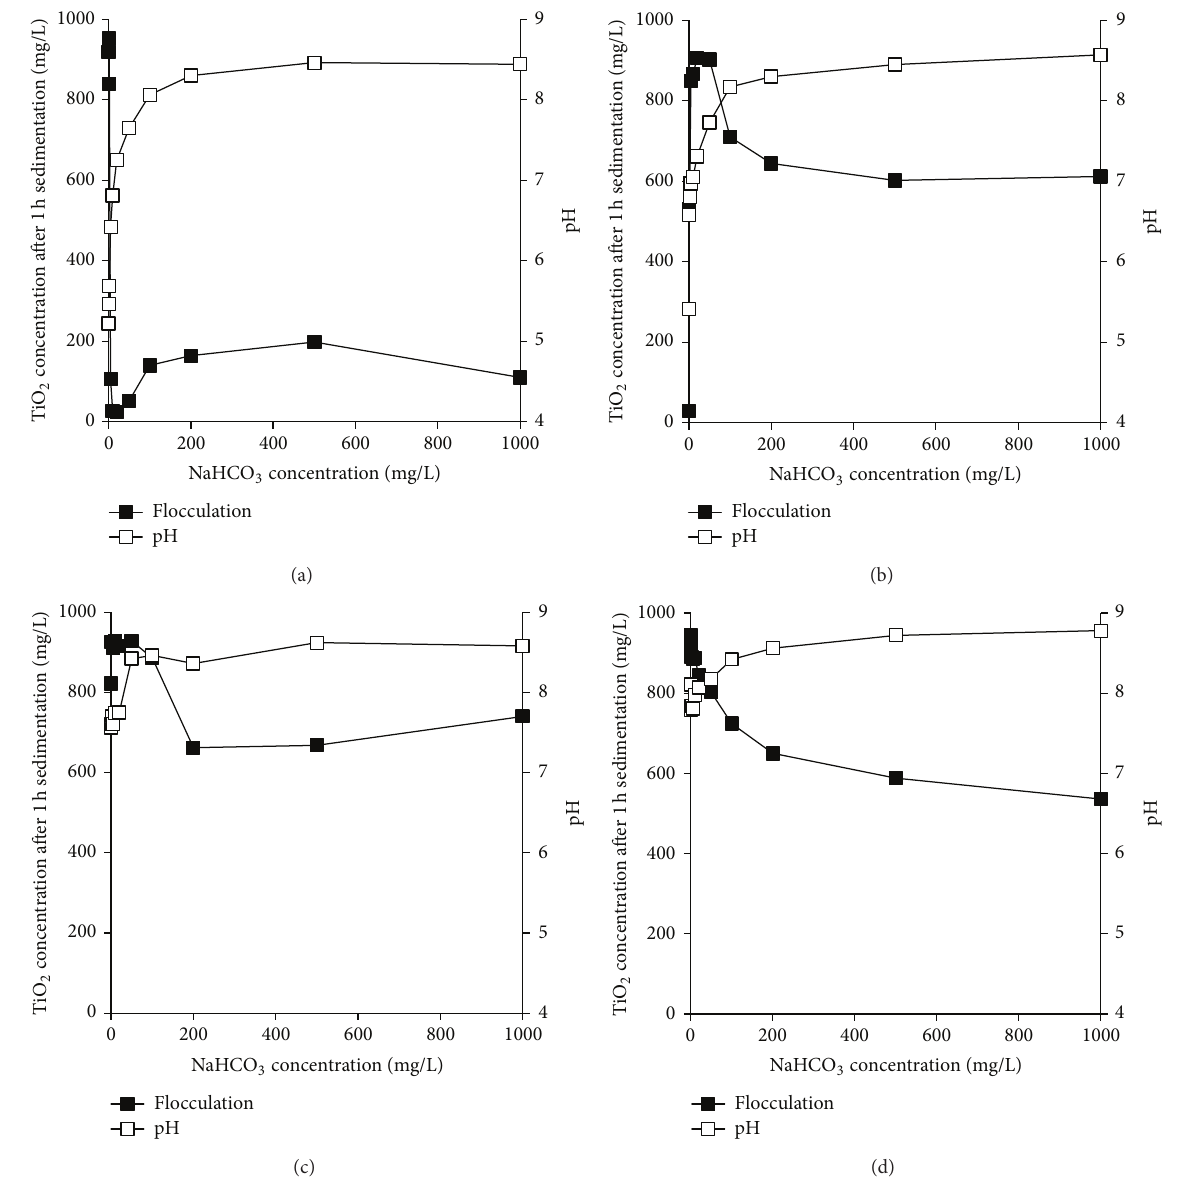
Figure 3: Photocatalyst flocculation and pH in 1g/L TiO 2 “P25” suspensions in aqueous solutions with no (a), 10 (b), 20 (c), and 50 mg/L (d) humic acid sodium salt, HANa, at different NaHCO 3